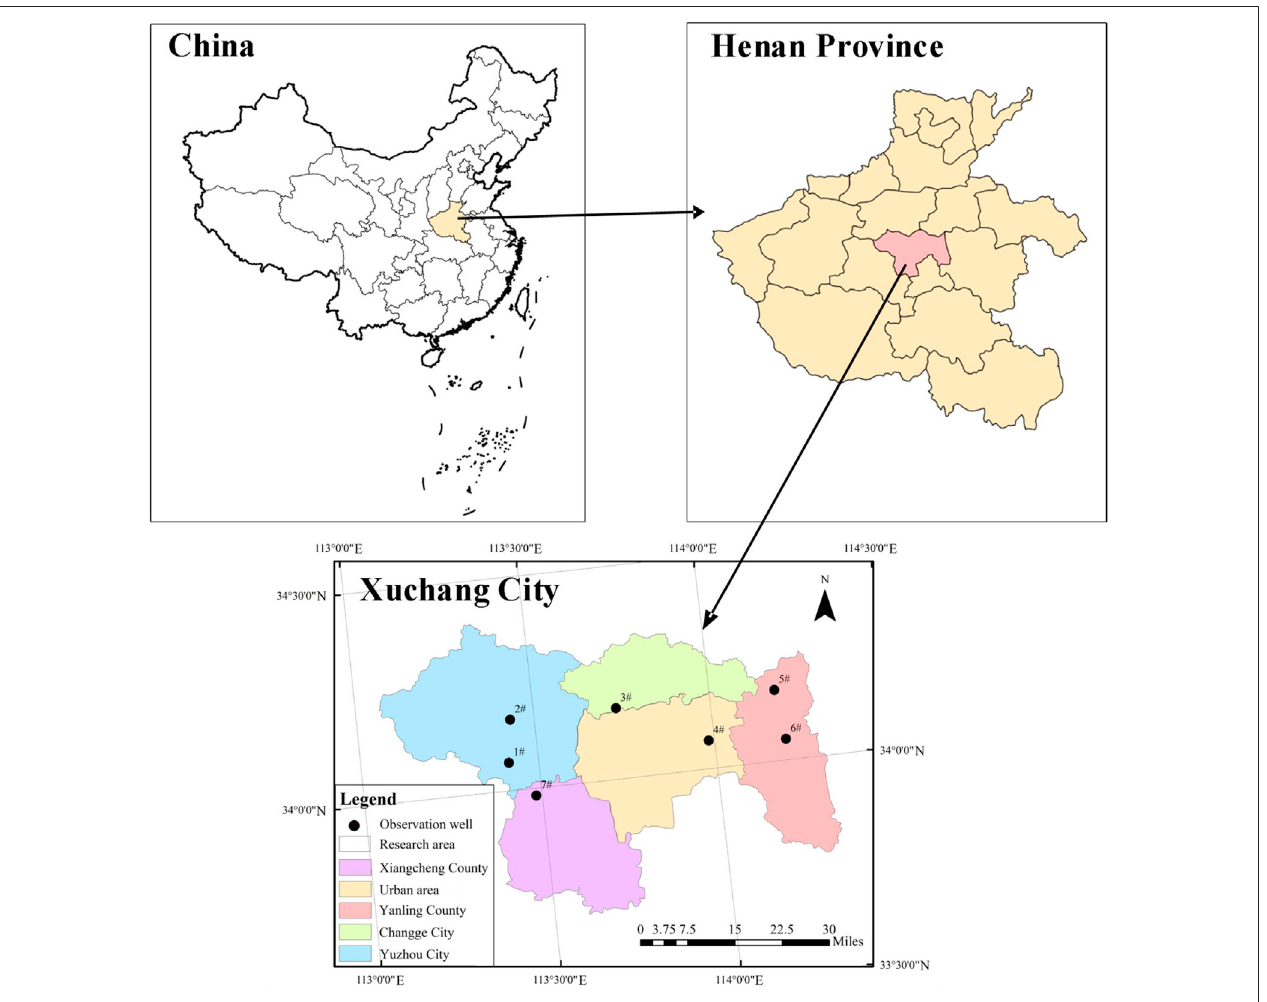
FIGURE 2 | Location of the study area and the seven observation